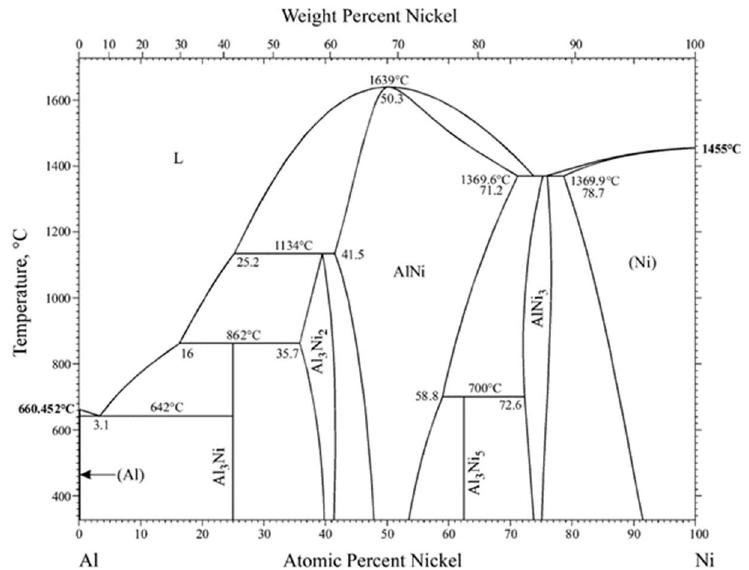
Figure 4. Al-Ni phase diagram. Reprinted/adapted with permission from Ref. [21]. 2019, Springer